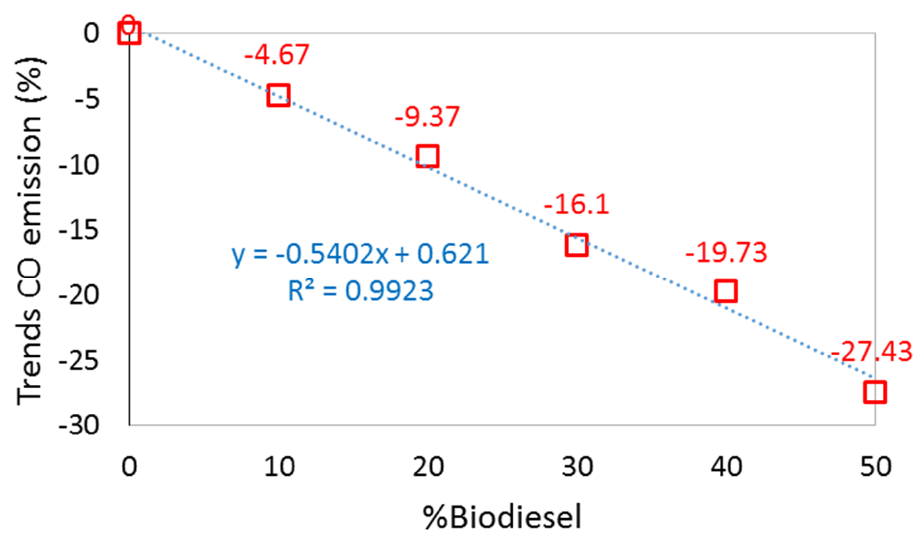
Figure 9. Trending CO emission follows biodiesel blends.